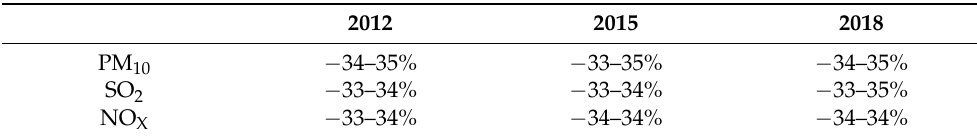
Table 2. Uncertainty ranges of PM 10 , SO 2 , and NO X emissions of China’s independent coking industry in 2012, 2015, and